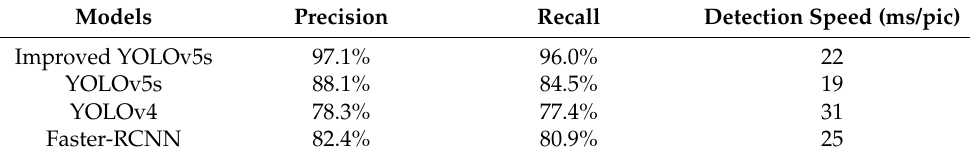
Table 3. Improved YOLOv5s model compared to YOLOv5s, YOLOv4, and